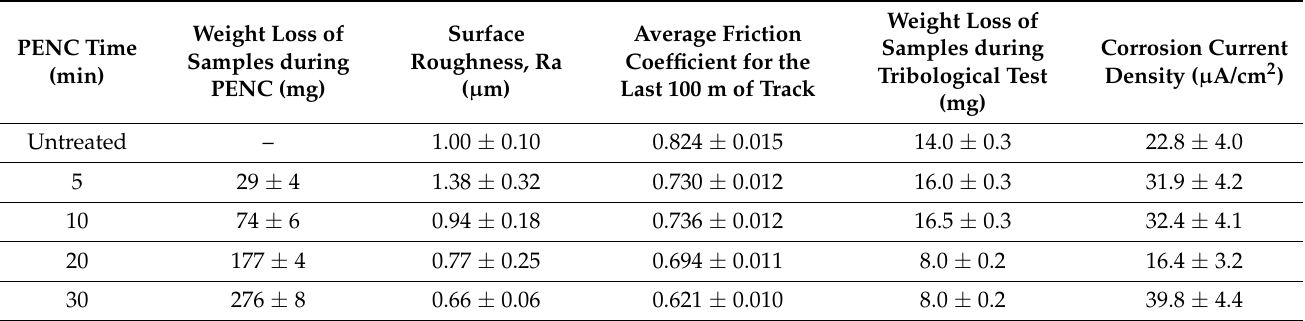
Table 1. Conditions of PENC and results of the samples’